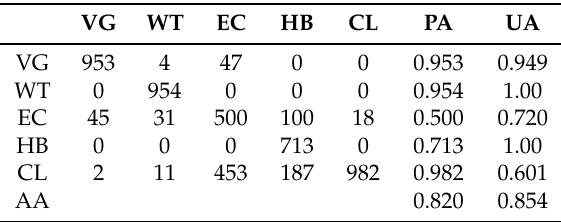
Table 14. Confusion matrix of the CART in the second